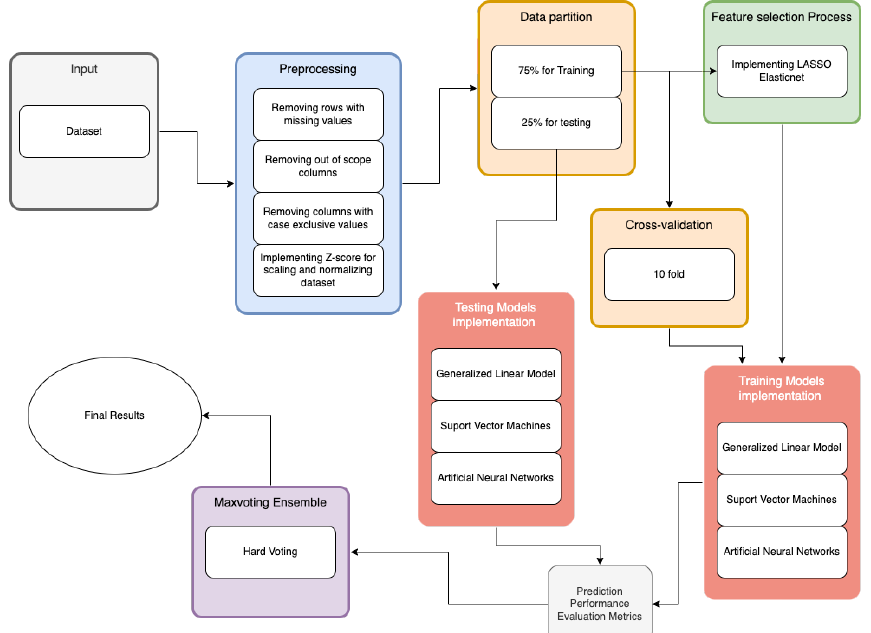
Figure 1. Flowchart of the proposed methodology.